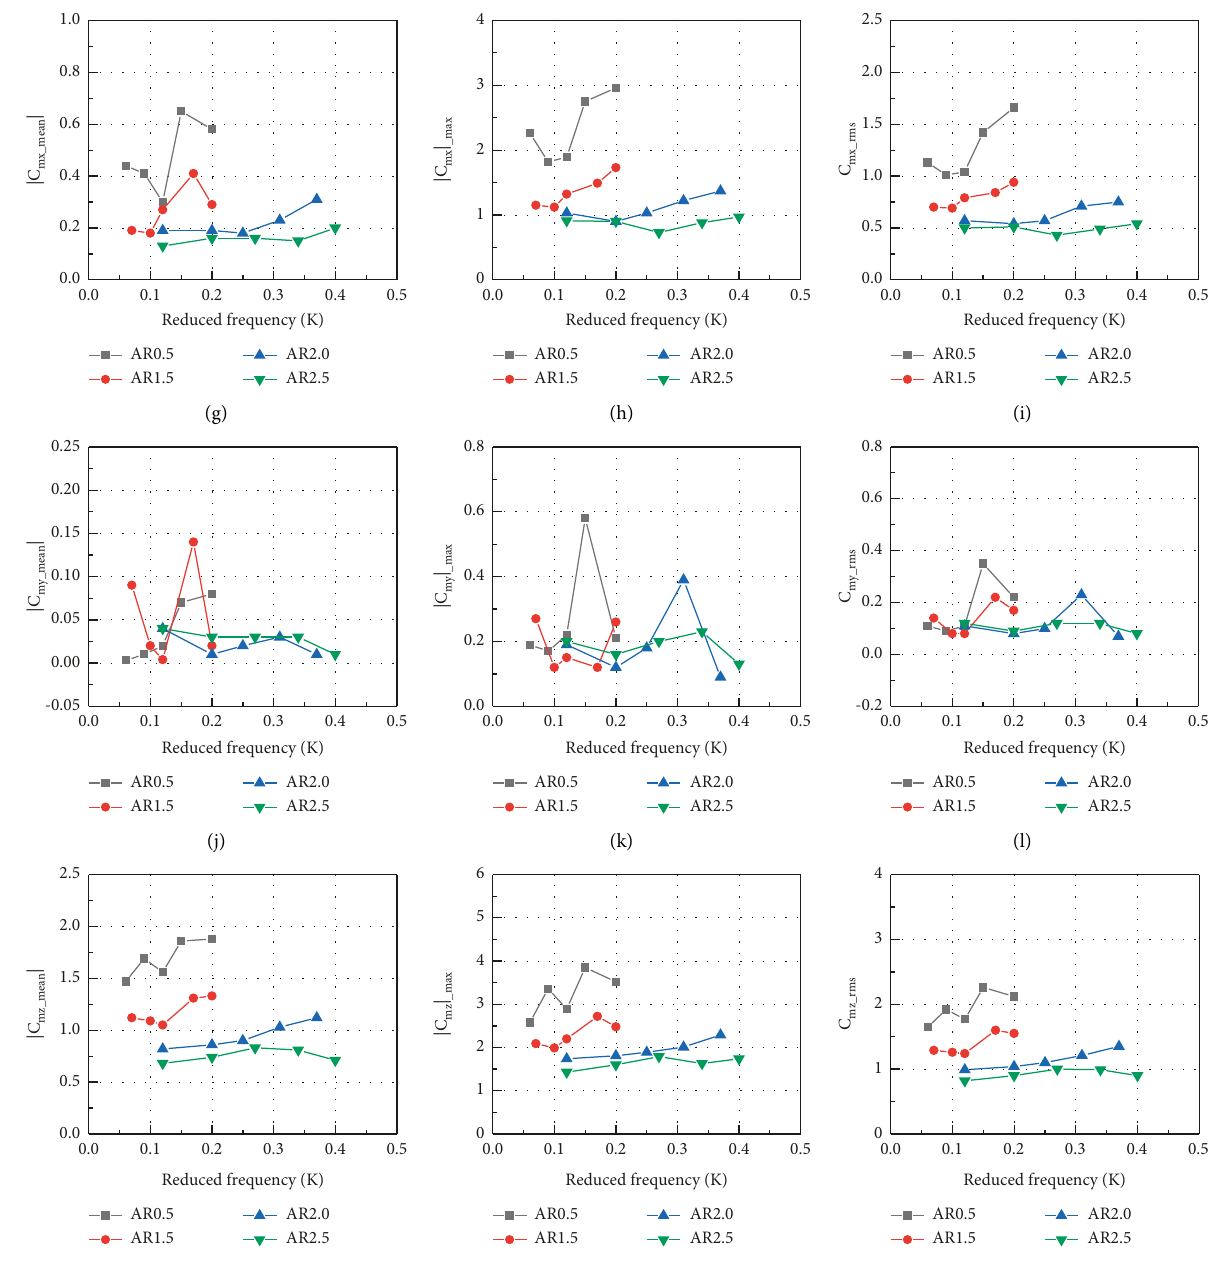
Figure 11: Mean, maximum, and root mean square values of the aerodynamic coefficients with respect to the reduced frequency when an antenna with different aspect ratios is rotating azimuthally: (a) | C x _mean |, (b) | C x | _max , (c) C x _rms , (d) | C z_mean |, (e) | C z | _max , (f) C z _rms , (g) |